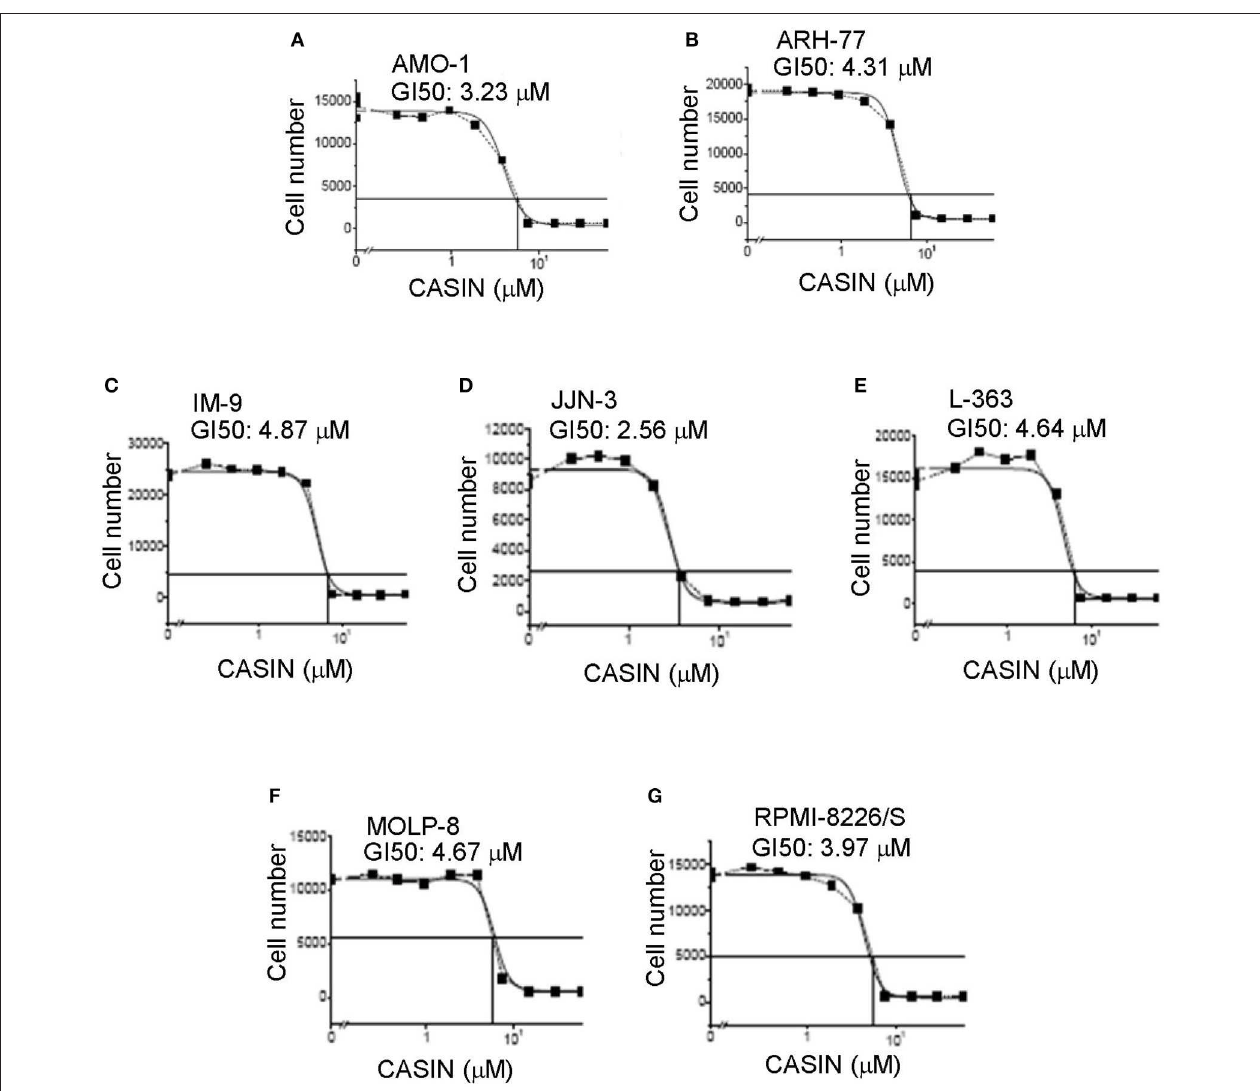
FIGURE 2 | Half-maximal growth inhibitory concentration (GI50) of CASIN ranges from 2.56 to 4.87 µ M in different MM cell lines. (A) GI50 of AMO-1 cells. (B) GI50 of ARH-77 cells. (C) GI50 of IM-9 cells. (D) GI50 of JJN-3 cells. (E) GI50 of L-363 cells. (F) GI50 of MOLP-8 cells. (G) GI50 of RPMI-8226/S cells. Indicated cell lines were plated at 2,000 cells/well and treated with or without different concentrations of CASIN for 3 days. Cell numbers were then counted. Data are representative of three independent experiments.